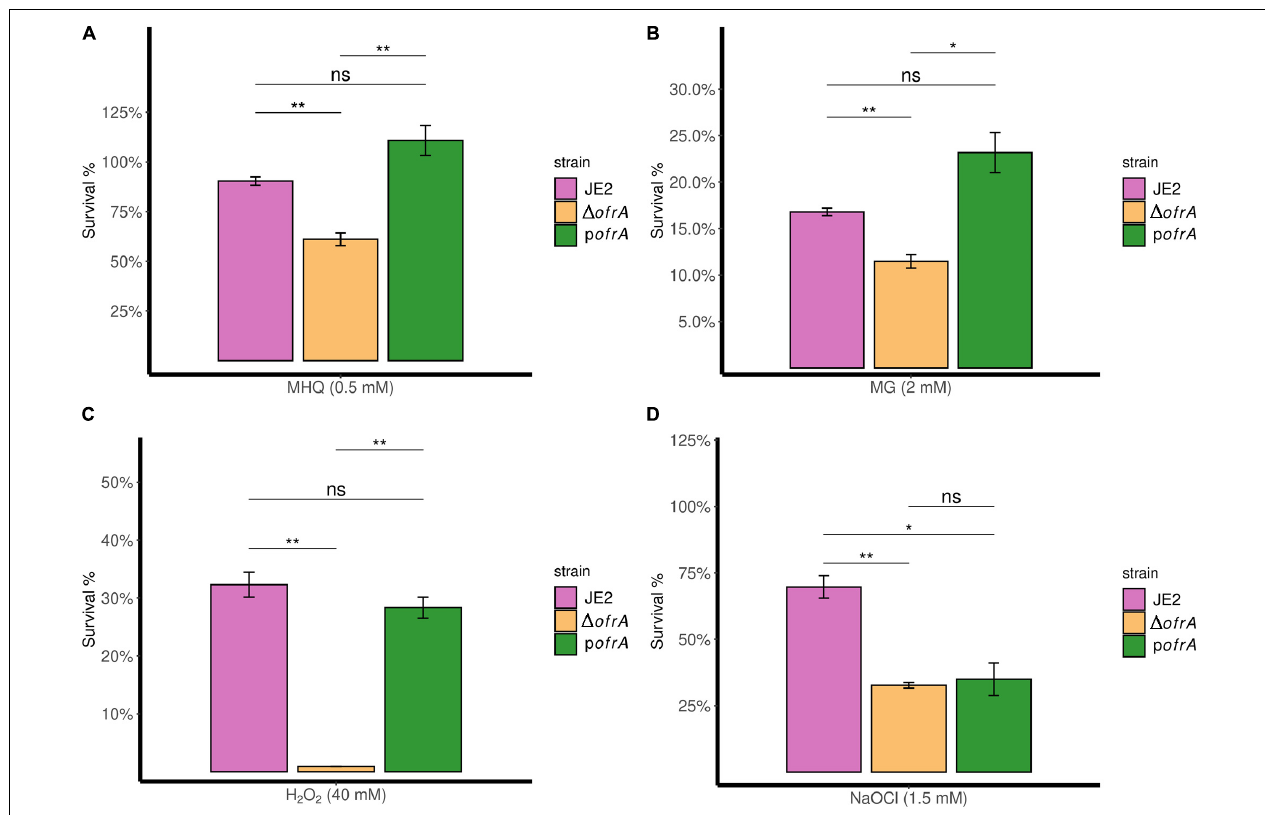
FIGURE 3 | OfrA provides S. aureus resistance against quinone stress, toxic aldehydes, oxidative, and hypochlorite stresses. Bacterial survival assays in RES (MHQ and MG), ROS (H 2 O 2 ), and RCS (NaOCl). The three strains; JE2, (cid:49) ofrA , and p ofrA were allowed to grow until the logarithmic phase (OD 600 = 0.4–0.6). Bacterial pellets were washed with sterile 1 × PBS, and the OD 600 were adjusted to 0.4 in fresh RPMI. We added: (A) 0.5 mM MHQ for 3 h, (B) 2 mM MG for 3 h, (C) 40 mM H 2 O 2 for 1 h, or (D) 1.5 mM NaOCl for 30 min. Samples were taken from the untreated control (for normalization) or with the stress conditions after the indicated time points for CFU determination using SP-SDS method on LB agar. Data represent four–five biological replicates. Error bars represent the standard error of